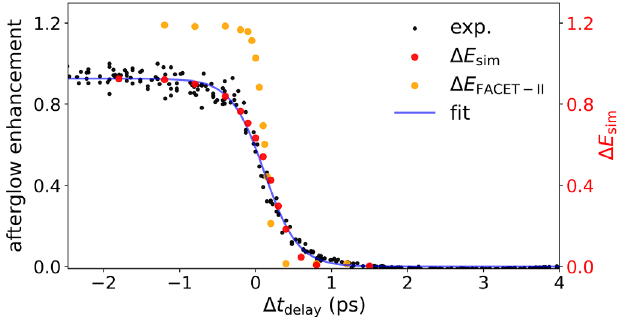
FIG. 5. Experimental time-of-arrival scan over 256 consecutive < 4 . 0 ps. Black: experimental shots within − 2 . 5 ps < Δ t delay normalized afterglow enhancement. Blue: sigmoid fit for exper- imental data. Red: normalized energy transferred into the plasma from PIC simulations. Orange: a FACET-II-class beam yields a substantially steeper